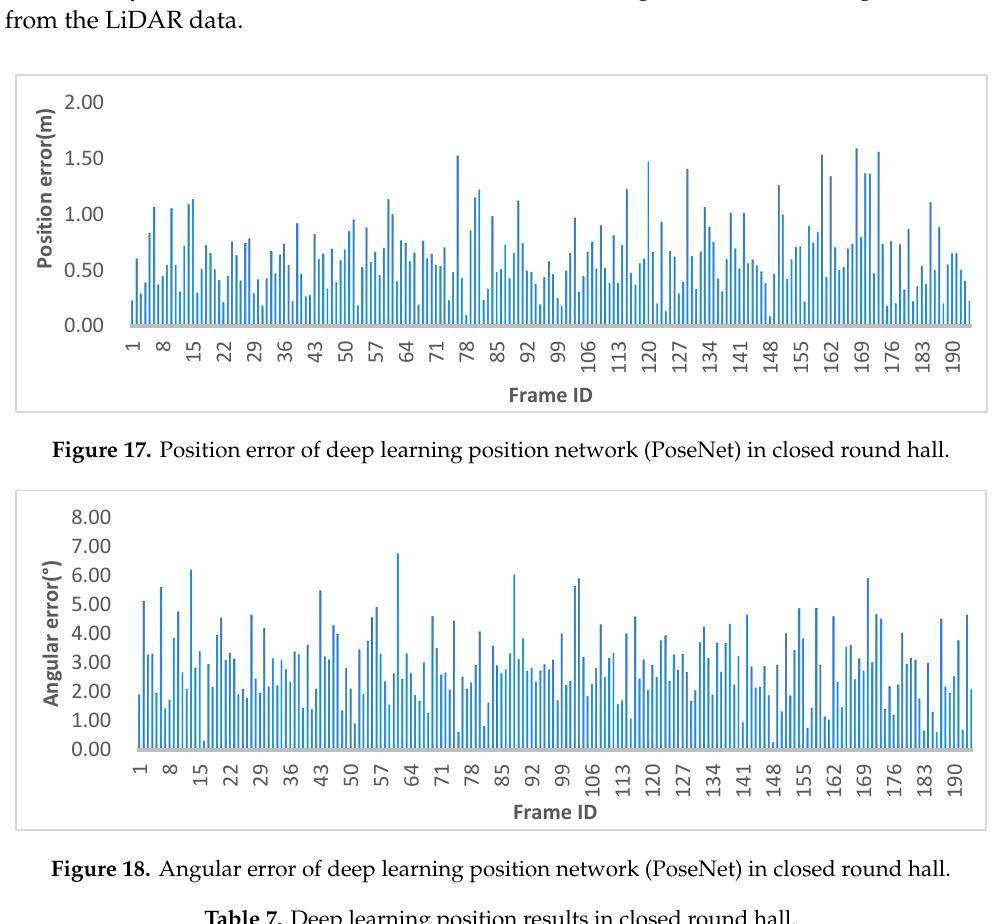
( d ) Figure 16. ( a ) Registration between models constructed by ORB-SLAM2 and LiDAR point cloud data model rendered in green. ( b ) Registration between models constructed by the proposed method and LiDAR point cloud data. ( c ) Sparse map constructed by the proposed method with camera trajectory overlay. ( d ) Comparison of the camera trajectories: camera trajectories produced by ORB-SLAM2 and the proposed method are shown in white and red, respectively. Table 6. Statistical results of matching error between the sparse maps generated by the two methods and the ground truth LiDAR data in closed round hall. Method